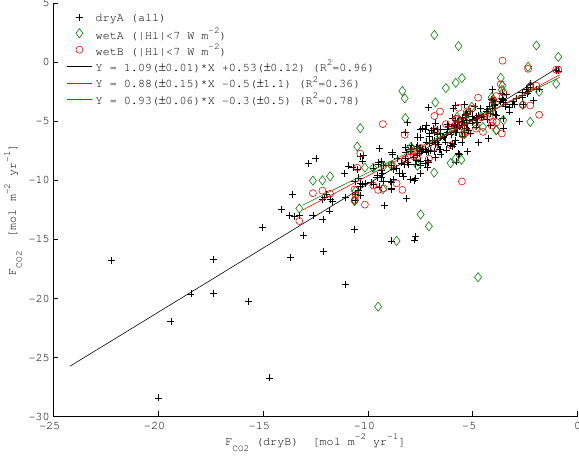
Fig. 6. Scatter plot of the CO 2 flux measurements (without PKT correction) from wetA , wetB and dryA against those from dryB . For wetA and wetB , only measurements with Hl ≤ 7Wm − 2 are used. Linear fit coefficients with standard deviation and the R 2 value are shown in the legend.